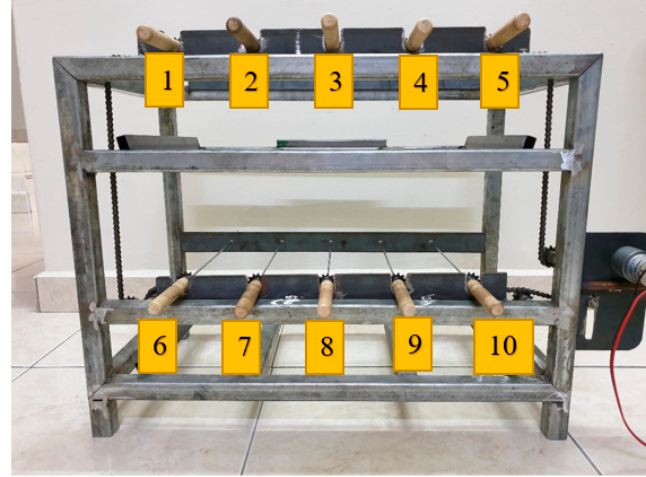
Figure 9. Rotisserie spit position numbering. Table 17. t -test results for temperature